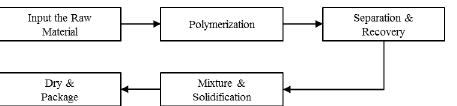
Figure 1. Flowchart of the styrene butadiene rubber (SBR) manufacturing process using emulsion polymerization.